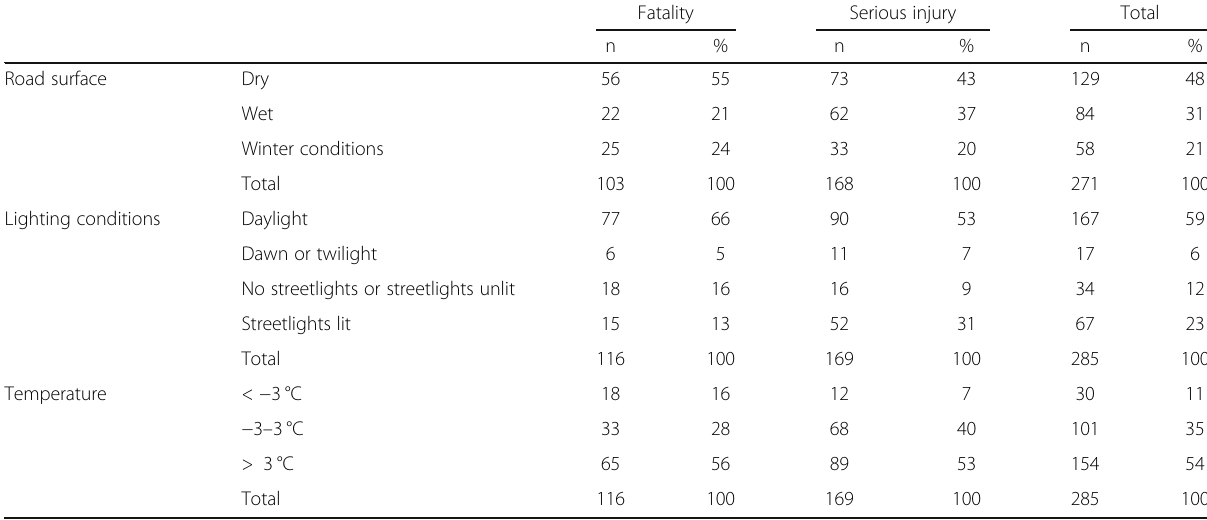
Table 3 Road surface (n = 271), lighting conditions (n = 285), temperature (n = 285) and weather conditions ( n = 275) according to pedestrian fatality and serious